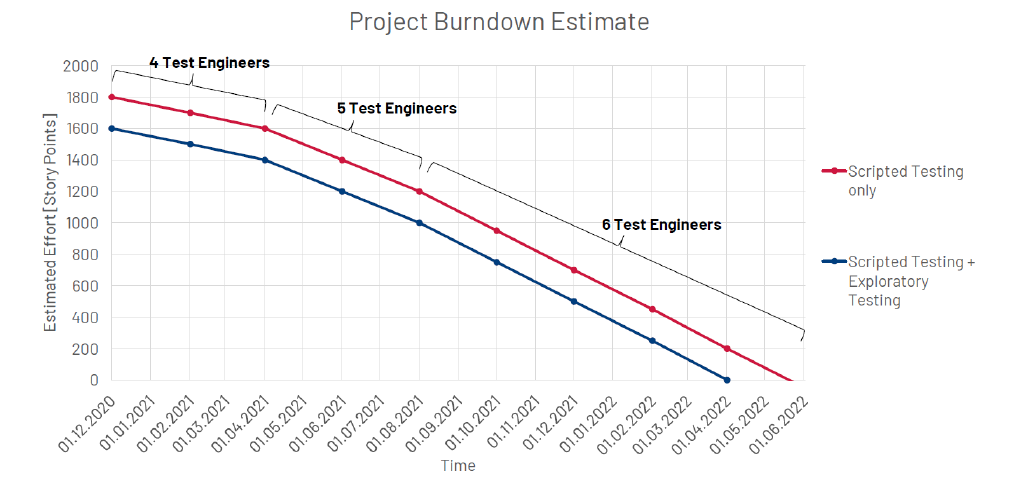
Figure 3. Original project estimates.